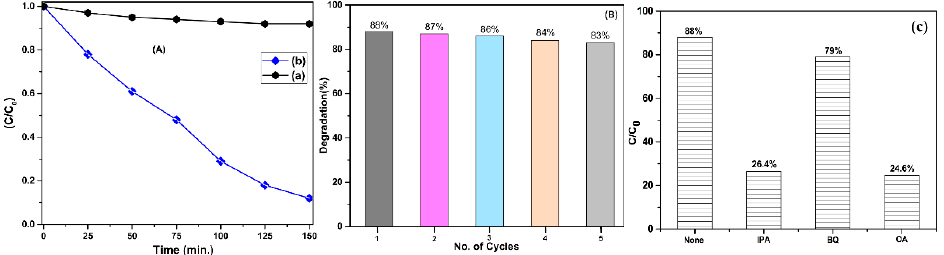
Figure 8. ( A ) Photocatalytic degradation of MB in the presence of sample (a) HAPs and (b) HAP-MnFe 2 O 4 . ( B ) Photodegradation efficiency of MB over HAP − MnFe 2 O 4 in different recycles. ( C ) Trapping experiments of active species in the photocatalytic reaction.